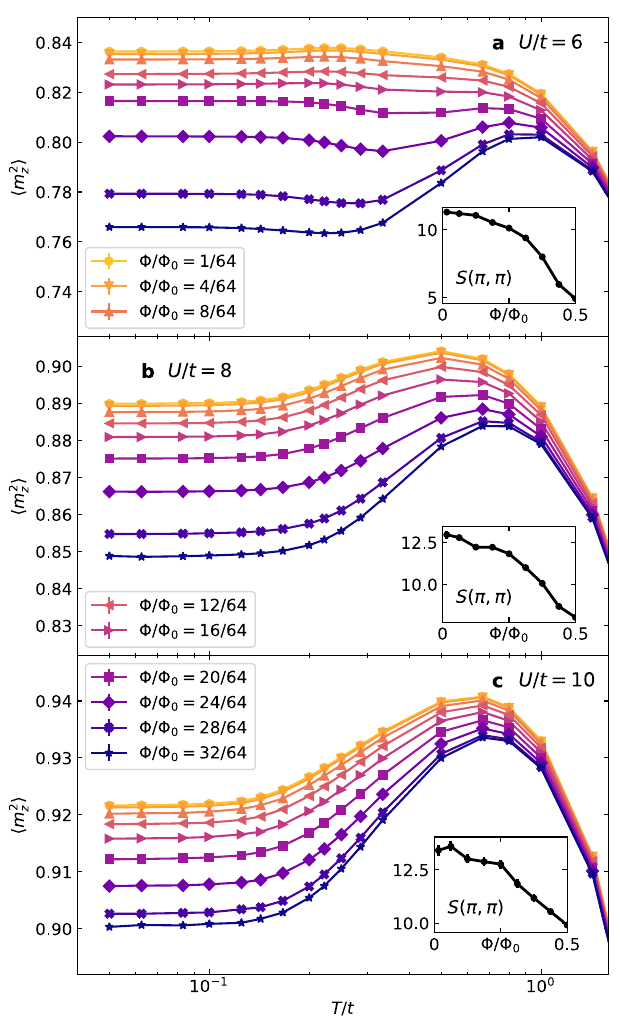
Fig. 4 Evolution of local moment and magnetic structure factor in the half- fi lled Hubbard – Hofstadter model. Temperature and fi eld dependence of local moment h m 2 z i at half fi lling. Insets display the fi eld dependence of magnetic structure factor S ( π , π ) at β t = 16 for magnetic fi eld strength Φ / Φ ∈ [0, 0.5]. a - c Correspond to Hubbard interaction strength U / t = 6 – 10, 0 respectively. Curves with the same color and marker type have the same magnetic fi eld strength across all panels. Error bars, corresponding to ±1 standard error of the mean, estimated by jackknife resampling, are smaller than the size of data